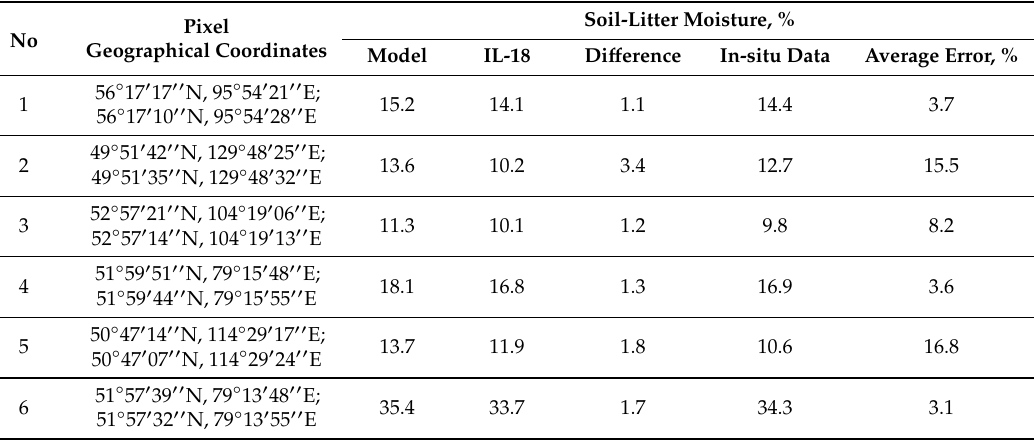
The pixel’s geographical coordinates correspond to its top left and bottom right angles.